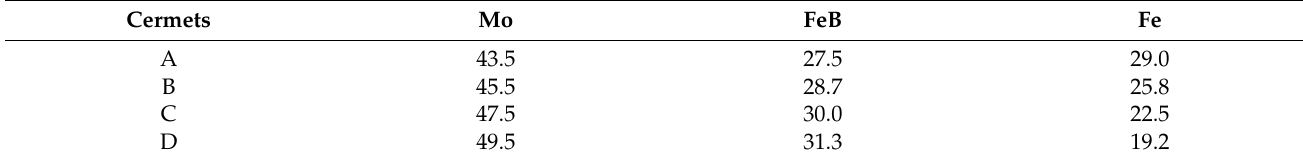
Figure 1. SEM micrographs of raw materials: ( a ) Mo; ( b ) FeB; ( c ) carbonyl Fe.